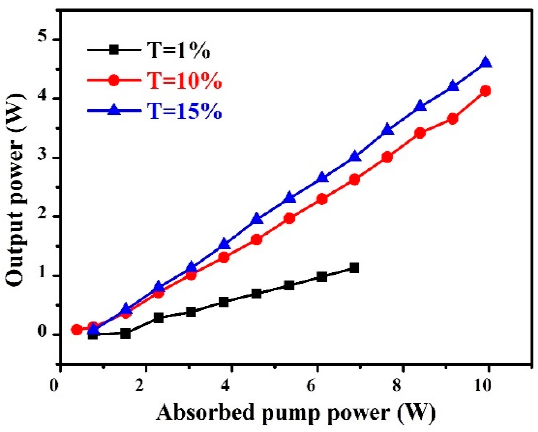
Figure 3. Output power versus absorbed pump power.